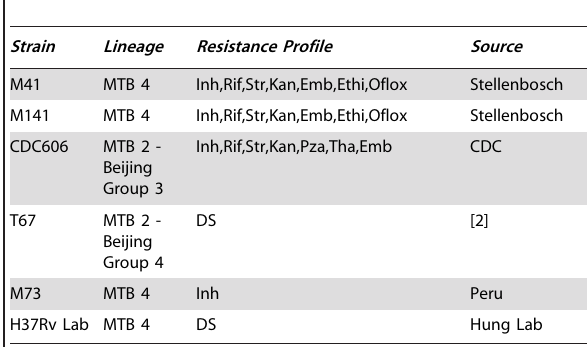
Table 1. Strains Displaying